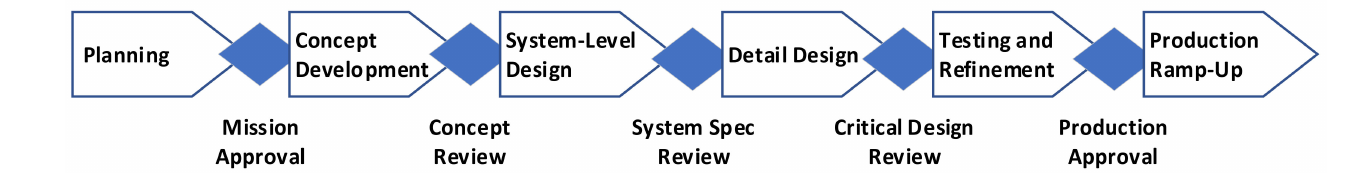
Figure 1. Product development process. Source: Authors’ own, based on [10].